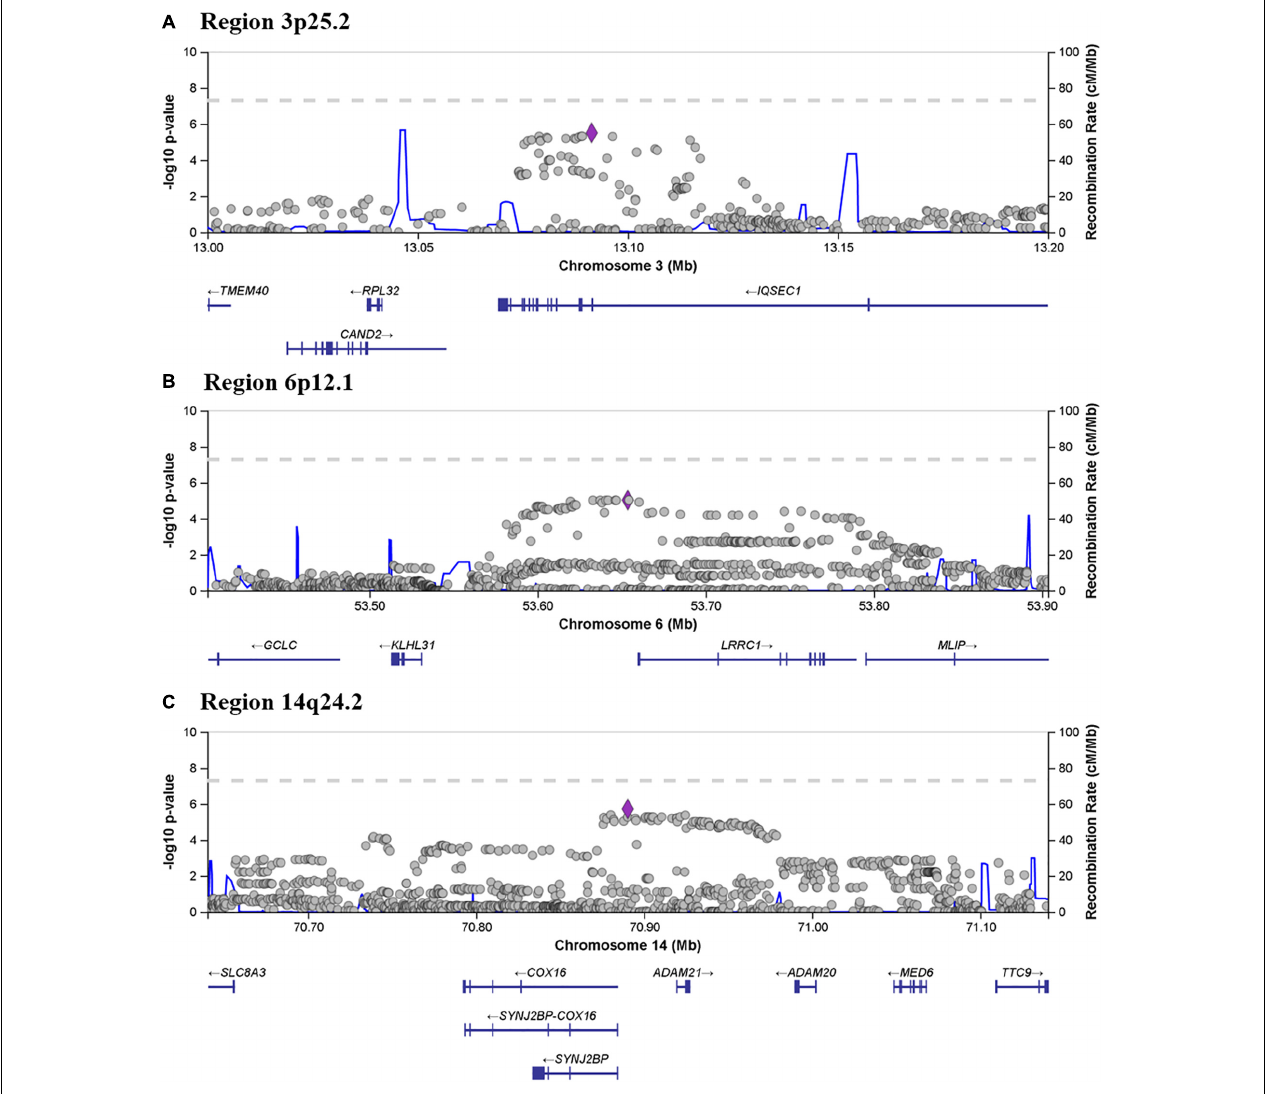
FIGURE 4 | Locus zoom showing associated and flanking regions in (A) 3p25.2, (B) 6p12.1 and (C) 14q24.2, where more than one SNP met the criteria for suggestive association. Genes located within and flanking each of the three regions are indicated below each